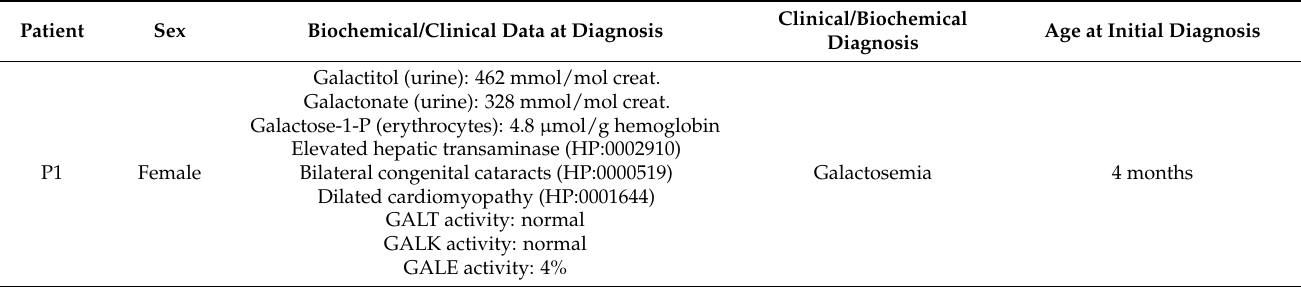
Table 1. Patient cohort. Biochemical data at diagnosis, clinical/biochemical diagnosis and age at initial